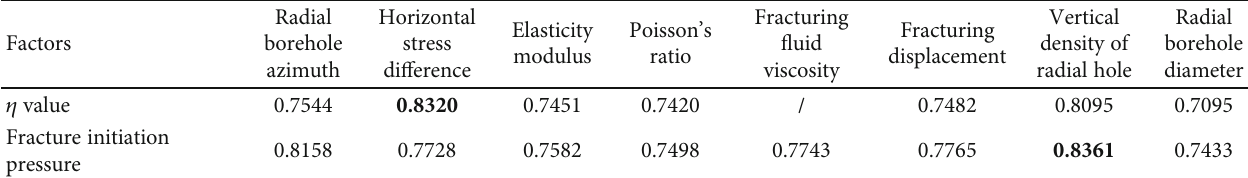
Table 3: Correlation